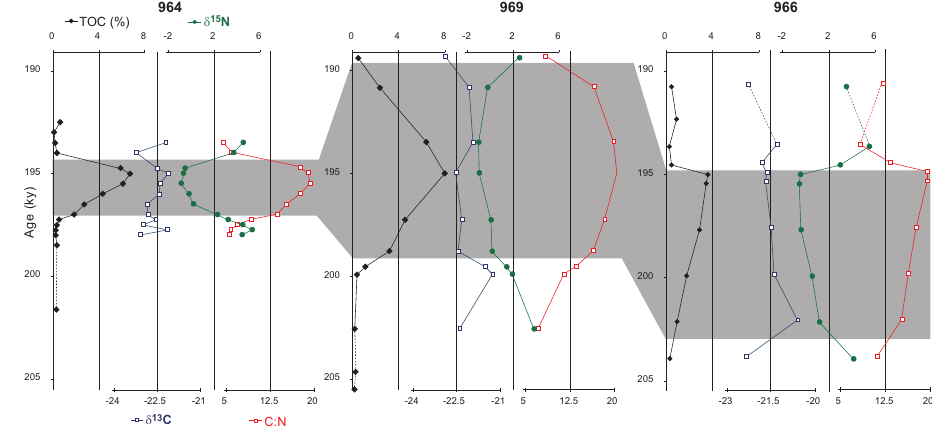
Fig. 10. TOC, C and N ratio, δ 15 N, δ 13 C for S7 at three studied sites. Shaded area corresponds to organic enriched sediments.